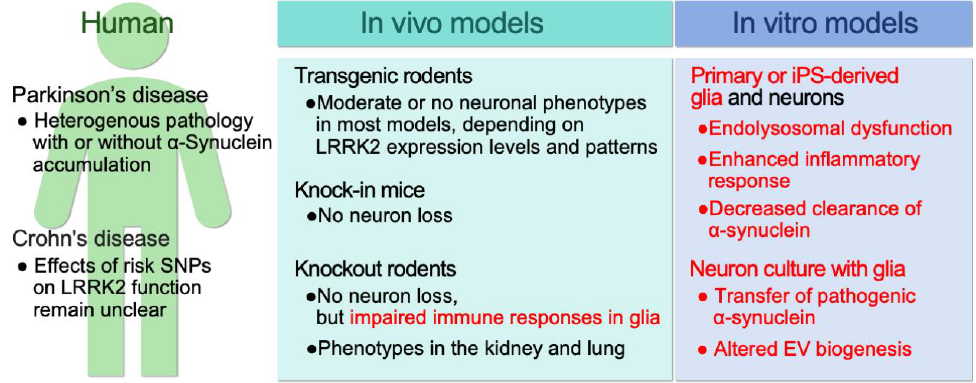
Figure 2. Overview of LRRK2 research, research problems, and issues to be resolved. In humans, risk SNPs have been found in Crohn’s disease as well as Parkinson’s disease. Currently, the impact of Crohn’s disease-associated SNPs on LRRK2 function is not clear [71,72]. Many in vivo models do not exhibit the pathological changes observed in Parkinson’s disease. However, LRRK2 knockout rodent models are an excellent tool to study the physiological function of LRRK2. In vitro models are superior for analysis at the organelle and molecular levels but have the disadvantage of not being able to reproduce the normal aging process and the brain environment. The results obtained from each of these models should be assessed in light of these considerations. The studies to which this review refers are indicated in red [11-14,73] . C. elegans and Drosophila models are excellent for molecular genetic analysis but will not be mentioned here. EV, extracellular vesicle.